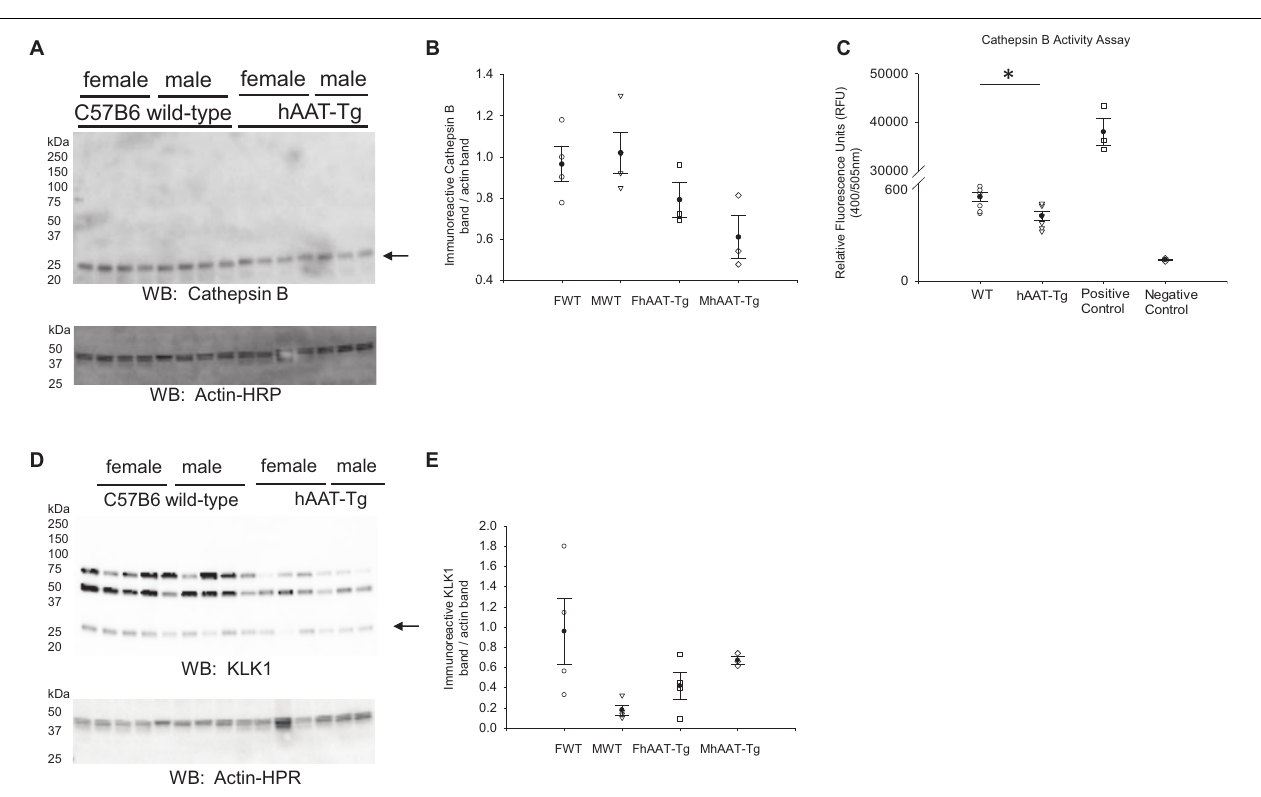
significantly lower in female hAAT-Tg mice compared to female wild-type mice maintained on a normal salt diet for the inactive cycle and active cycle ( Figures 3A,B ). There may be a slight underestimation of the blood pressure measurements for both groups although the mice were trained to the